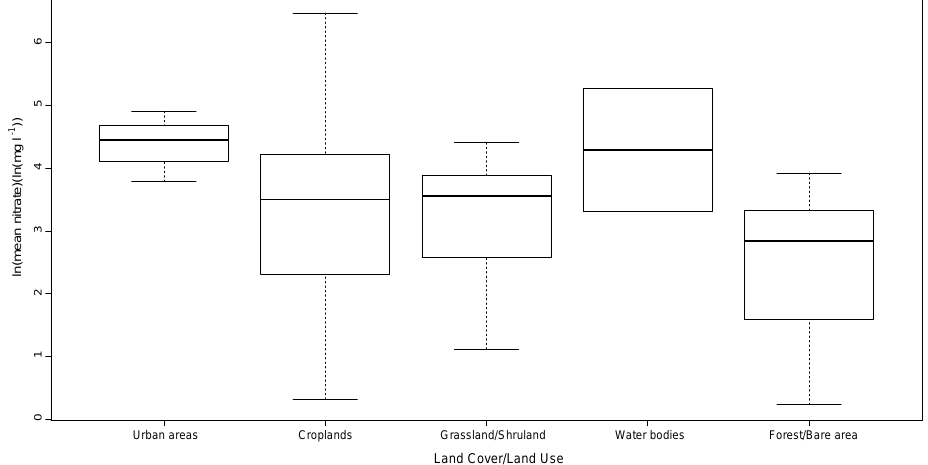
Figure 6. Log transformed mean nitrate concentration for different land use classes.